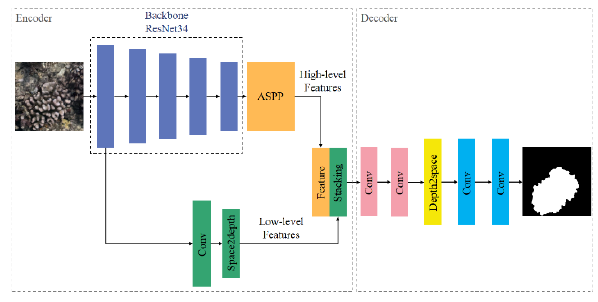
Figure 1. The structure of DeeperLabC for single-channel coral segmentation.